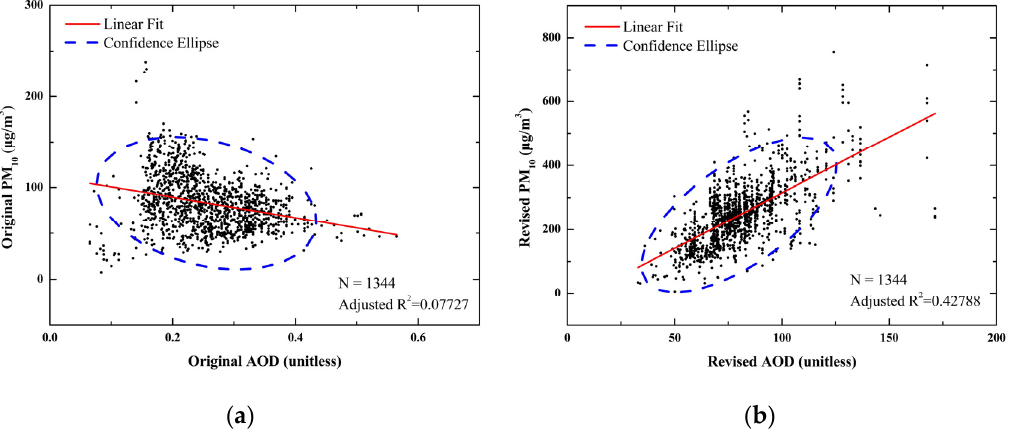
Figure 3. Scatter plot of original PM 10 against original AOD ( a ); and revised PM 10 against revised AOD ( b ) with linear regression and confidence ellipse of 95%.